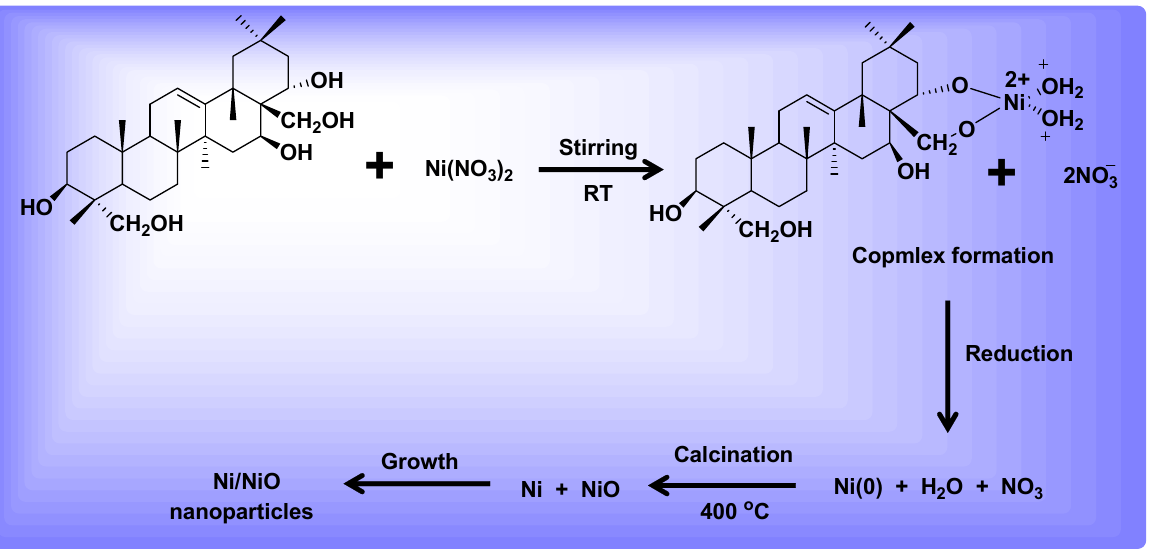
Figure 4. A possible reaction mechanism for the green synthesis of Ni/NiO NPs using biomolecules.